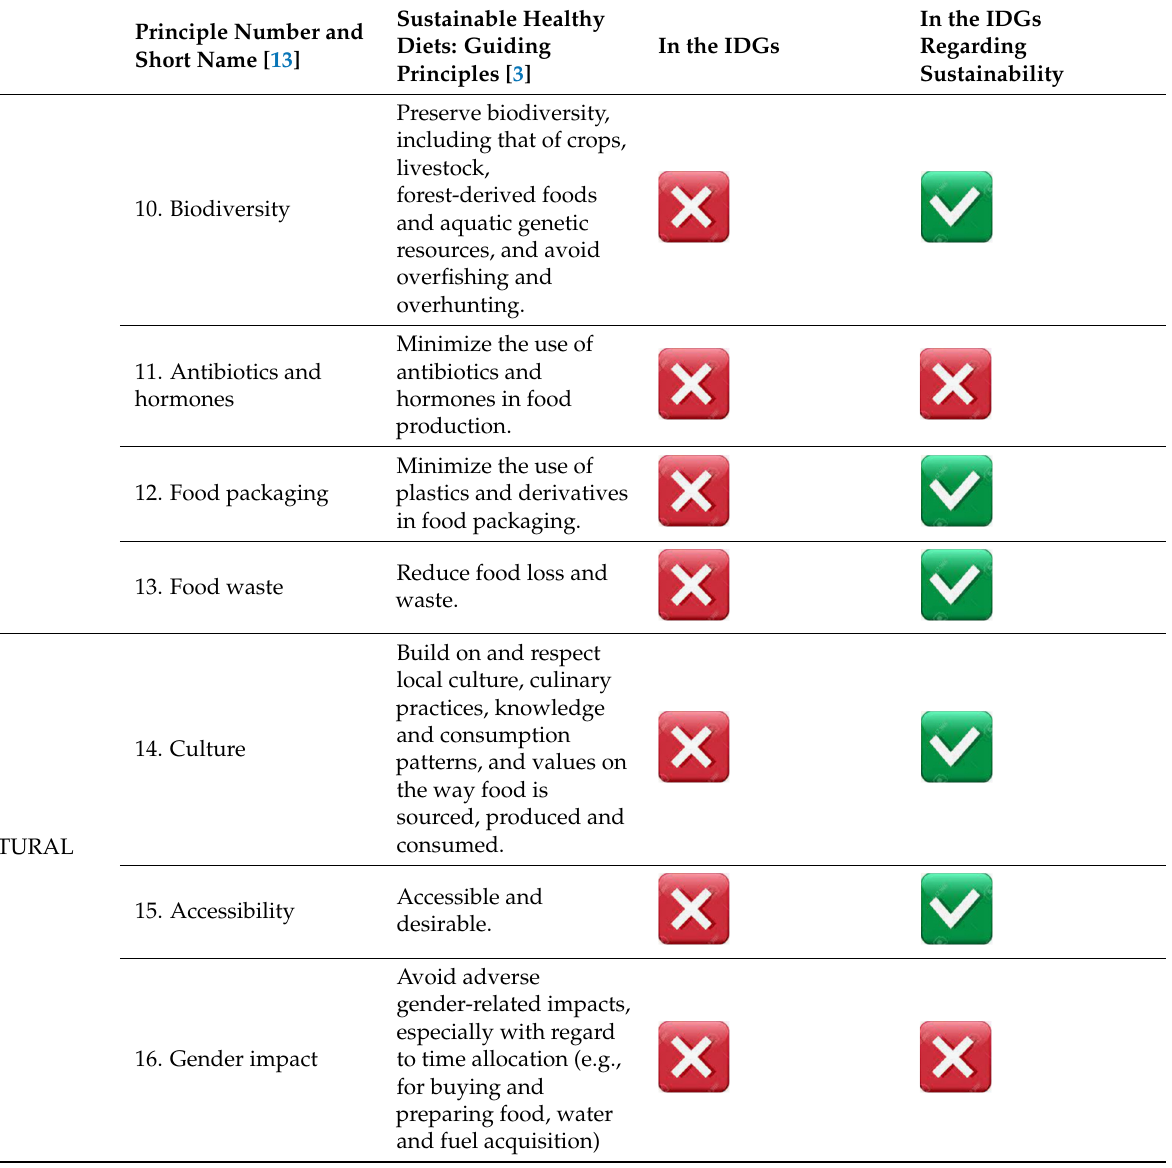
Table 1. The 16 guiding principles of a sustainable healthy diet in the IDGs regarding sustainability. Key to symbols: included; not included.